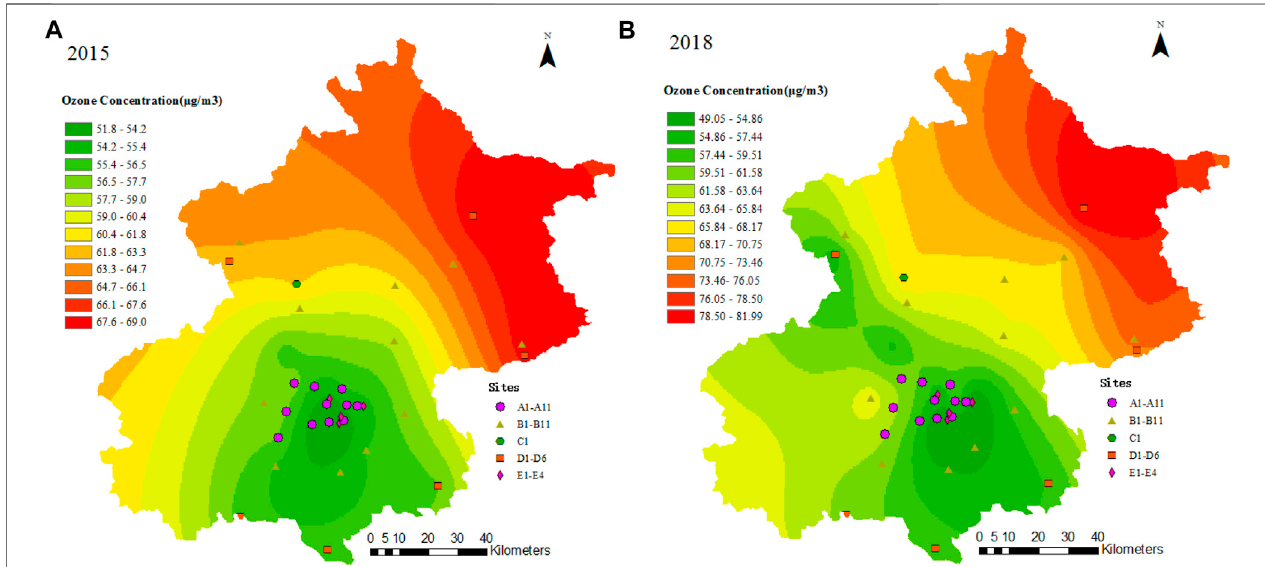
FIGURE 10 | Spatial distribution of O 3 concentration in Beijing in (A) 2015 and (B)